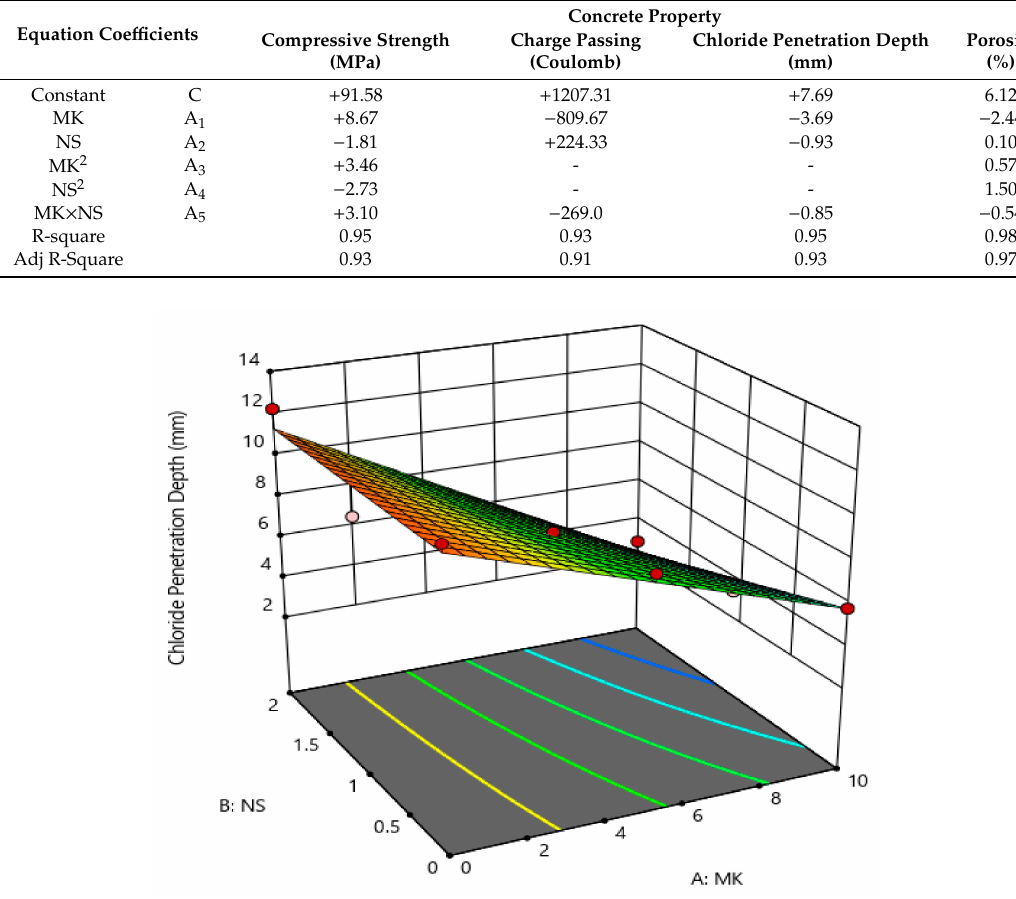
Figure 15. E ff ect MK and NS proportions on chloride